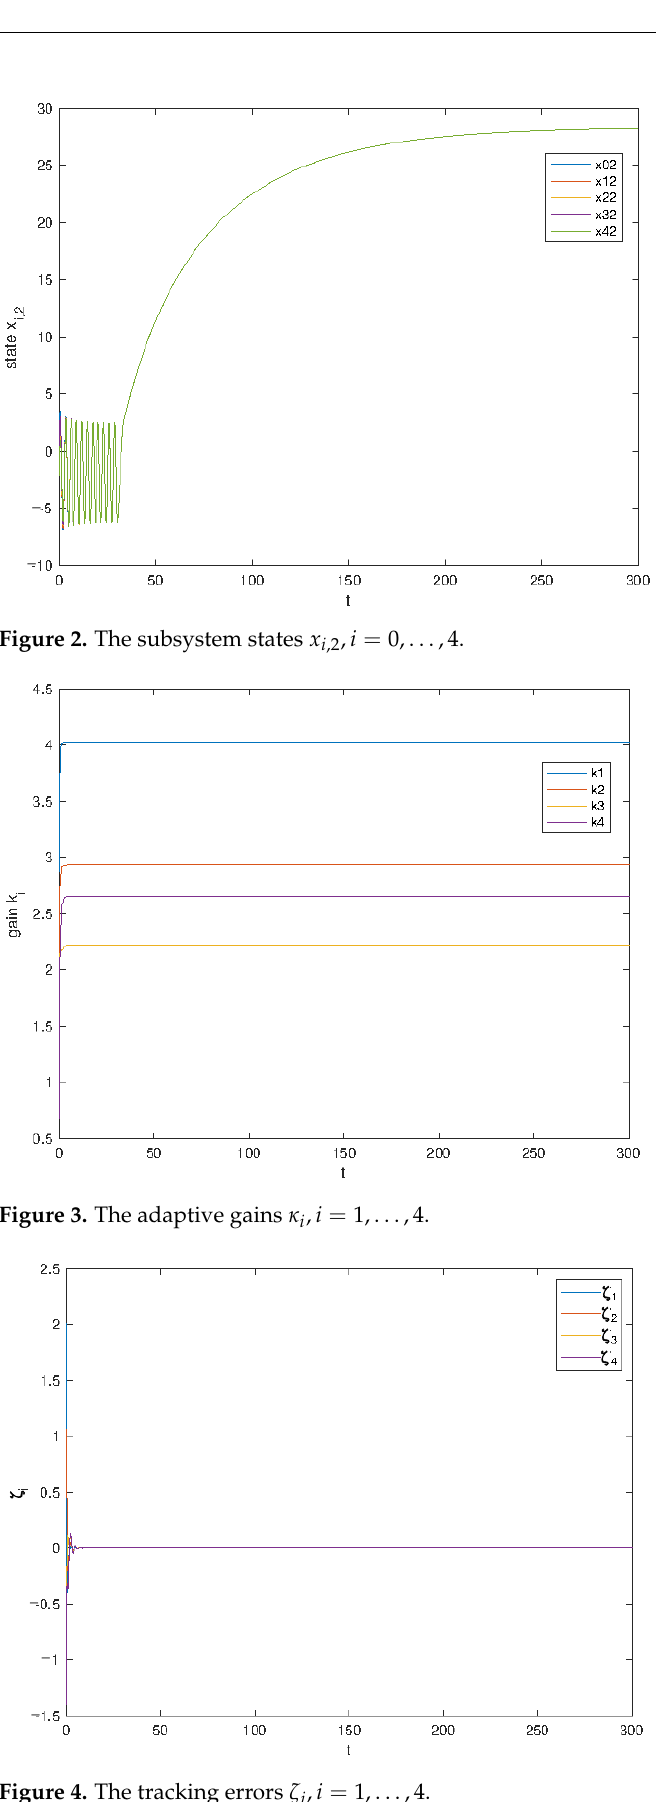
Figure 4. The tracking errors ζ i , i = 1, . . .